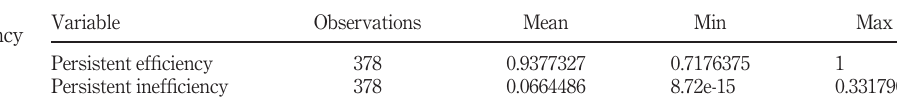
Figure 1. Transient inef fi ciency